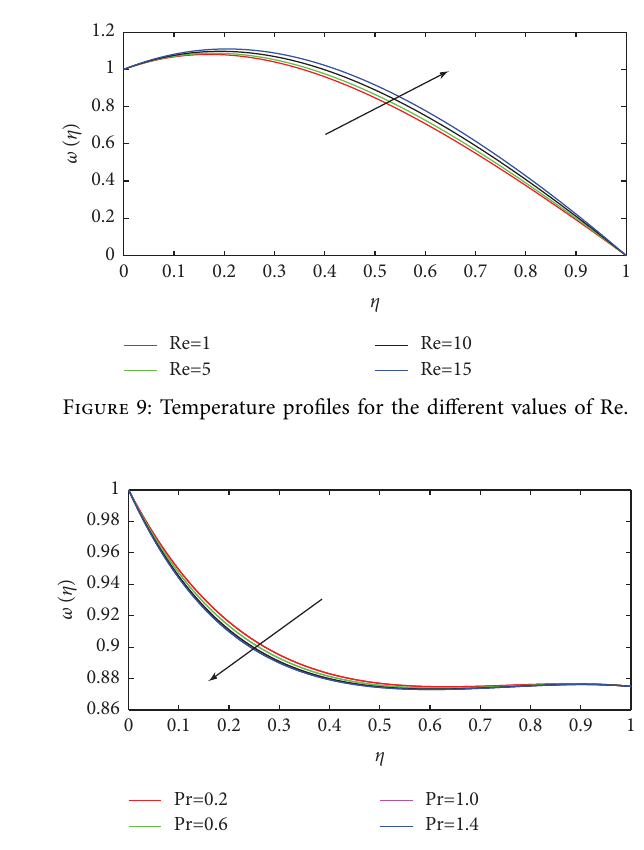
Figure 7: Velocity profles for the diferent values of λ .